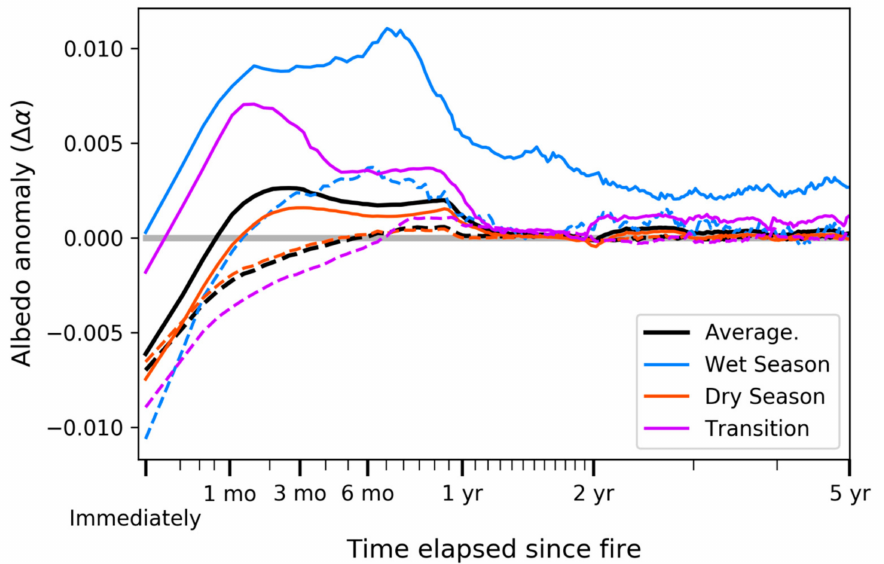
Figure 2. Evolution of albedo anomalies after African fires for the Northern (dotted line) and Southern (solid line) Hemisphere. Di ff erent colors represent di ff erent times of the year for fire occurrence. The wet season months are JJAS for the Northern Hemisphere and DJFM for the Southern Hemisphere. October, November, April and May are considered transition months for both hemispheres. Each line is the average of all fires that occurred within the given time of year weighted by the area of each fire. The whole year average (black) closely tracks the dry season (orange) average because most fires occur during the dry season. Note that the x-axis (time axis) is plotted on a logarithmic scale. We identified a general temporal pattern of albedo anomaly development. The lowest observed albedo anomaly was observed